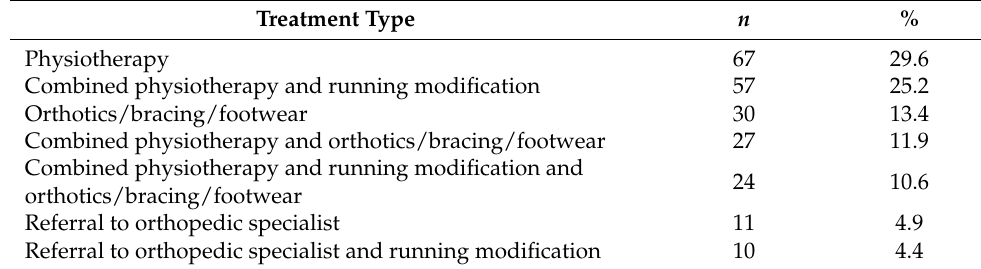
Table 2. Frequency and type of treatment reported in DREAMFAR